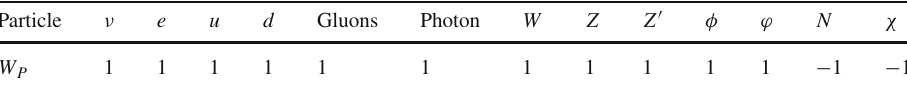
Table 2 Matter parity for the model particles